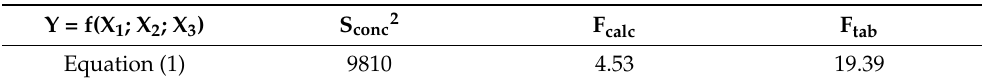
Table 3. Concordance verifying between the calculated non-linear model Equation (2) and the experimental results according to Table 1.